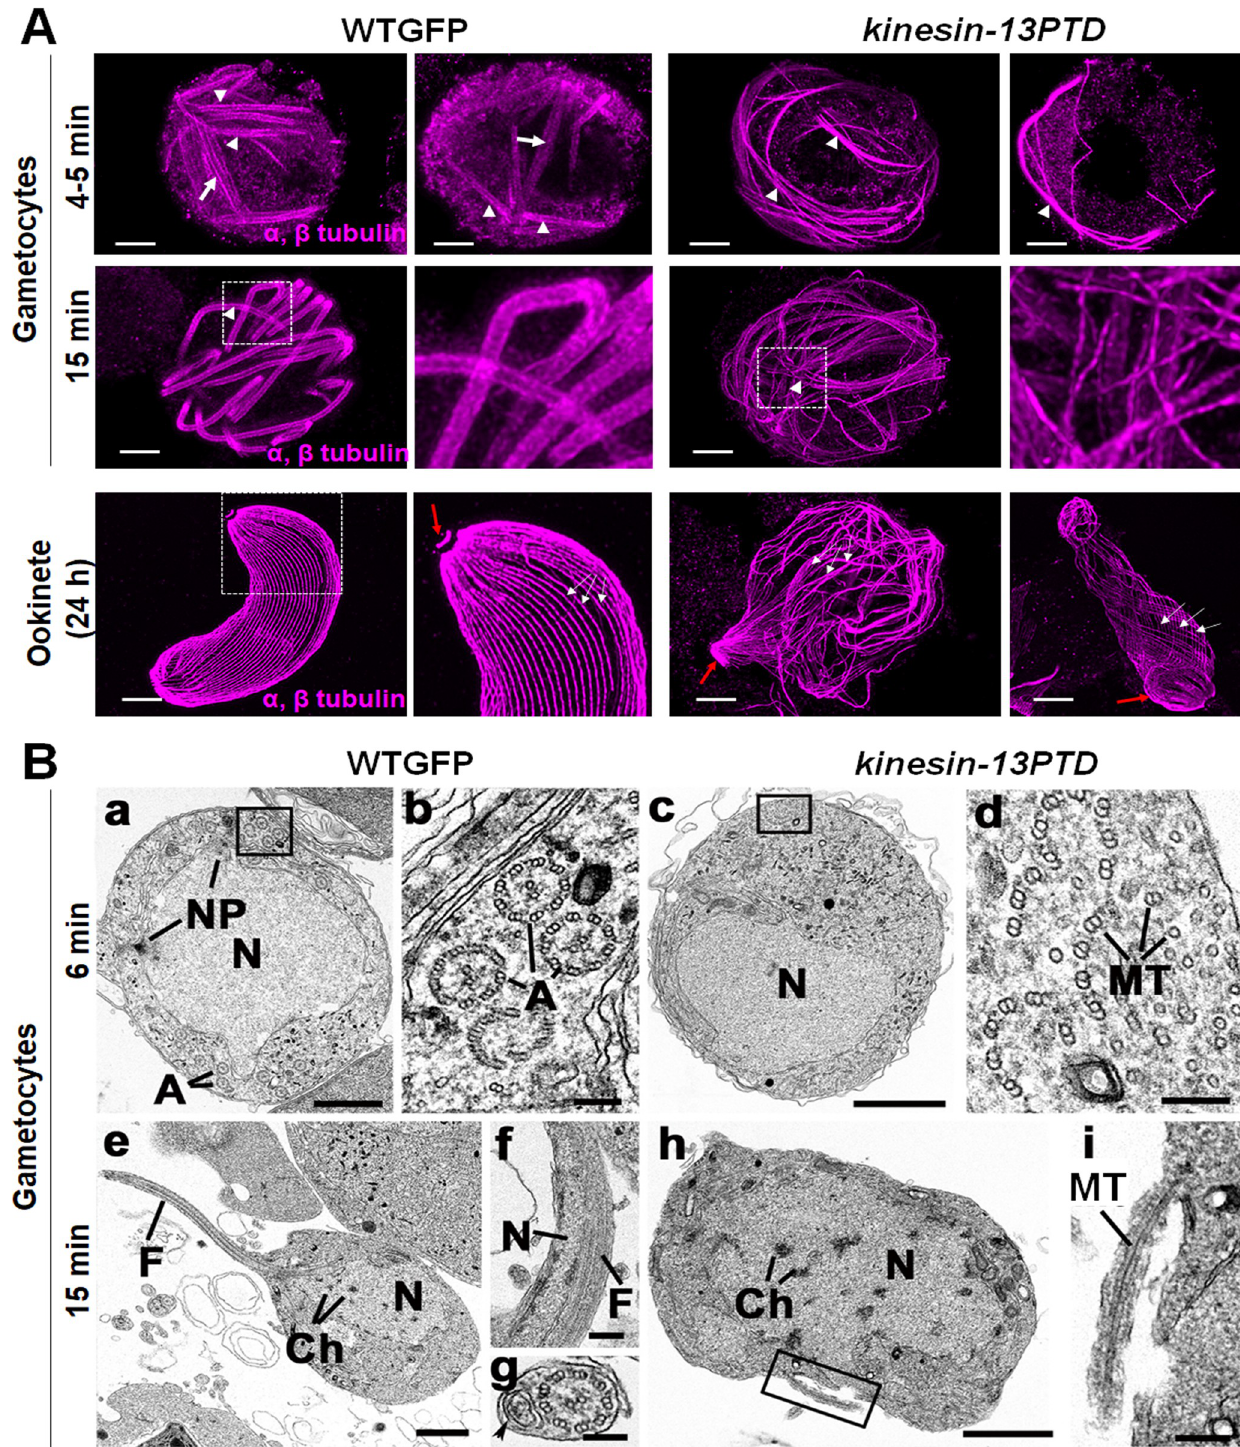
Fig 7. Ultrastructural analysis of WTGFP and kinesin-13PTD gametocytes and ookinetes. (A) Representative confocal images of expanded gametocytes of WTGFP and kinesin-13PTD lines stained for α - and β -tubulin (magenta) showing labelling of spindle (arrow) and axonemal MTs (arrowhead) at 4–5 min and axonemal MTs (arrowhead) at 15 mpa. Similarly, representative confocal images of expanded ookinetes of WTGFP and kinesin-13PTD lines stained for α - and β -tubulin (magenta) showing well-organised subpellicular MTs (white arrows) and apical tubulin ring (ATR, red arrows) in WTGFP ookinetes and disorganised MTs in kinesin-13PTD ookinetes. Scale bars = 1 μ m. (B) Electron micrographs of P . berghei male gametogenesis of WTGFP (a,